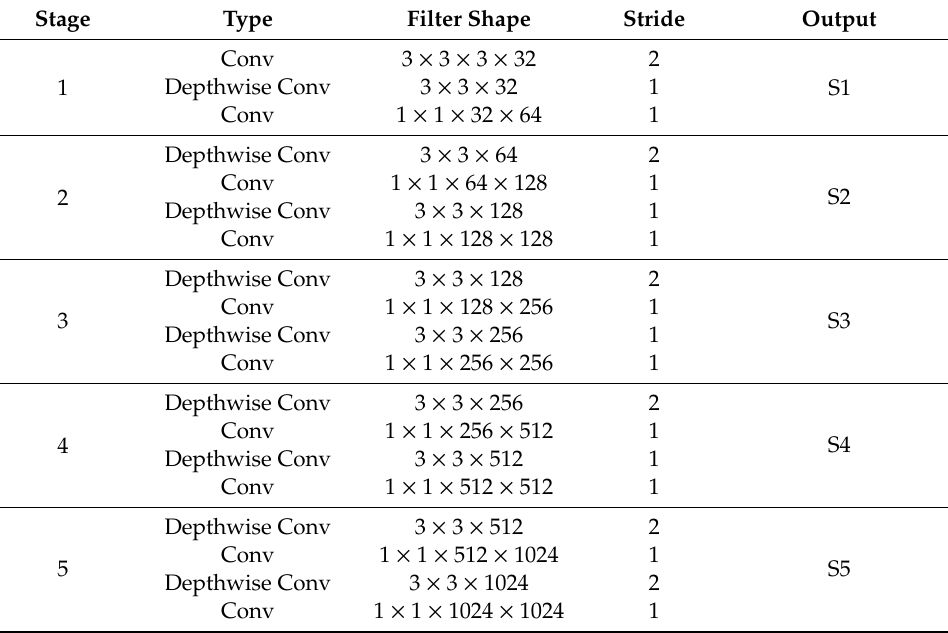
Table 3. Five stages of MobileNets after modification